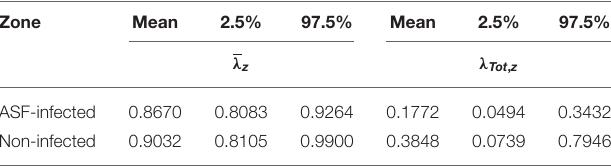
TABLE 3 | Posterior mean and 95% highest posterior density values for the total growth rate ( λ Tot , z ) and average monthly growth rate ( λ z ) per ASF management zone, obtained by averaging over all corresponding